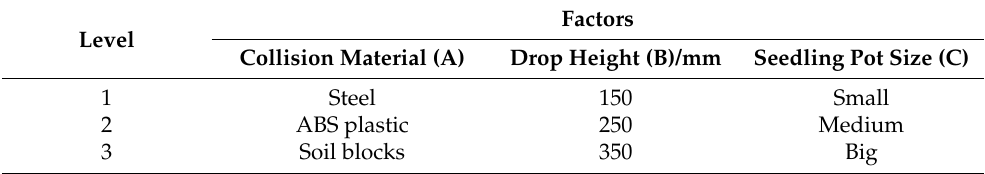
Table 2. Influencing factors and levels.